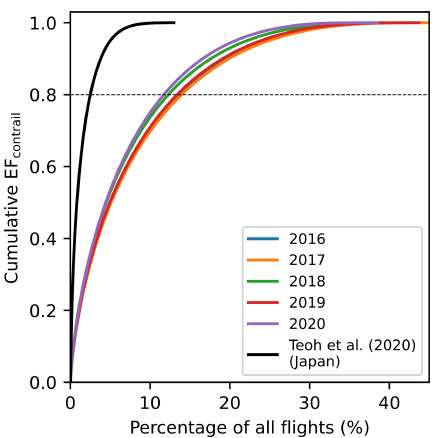
Figure 2. Cumulative density function of the total EF contrail vs. the percentage of flights. Individual coloured lines represent the results for each year (2016–2020) in the North Atlantic, and the black line shows the results from an earlier study in Japanese airspace (Teoh et al.,